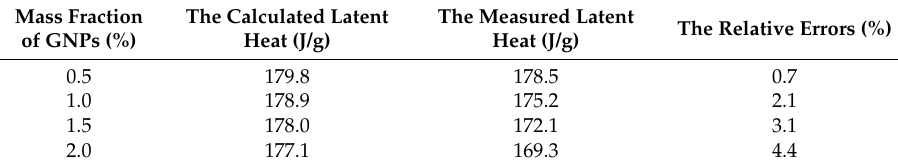
Table 2. Calculated and measured values of the melting latent heat of composites.